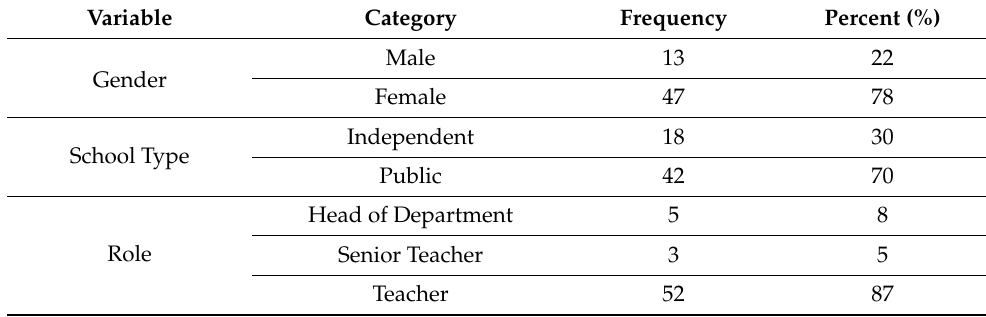
Table 1. Demographic profile of participants for the quantitative phase of the study ( n =